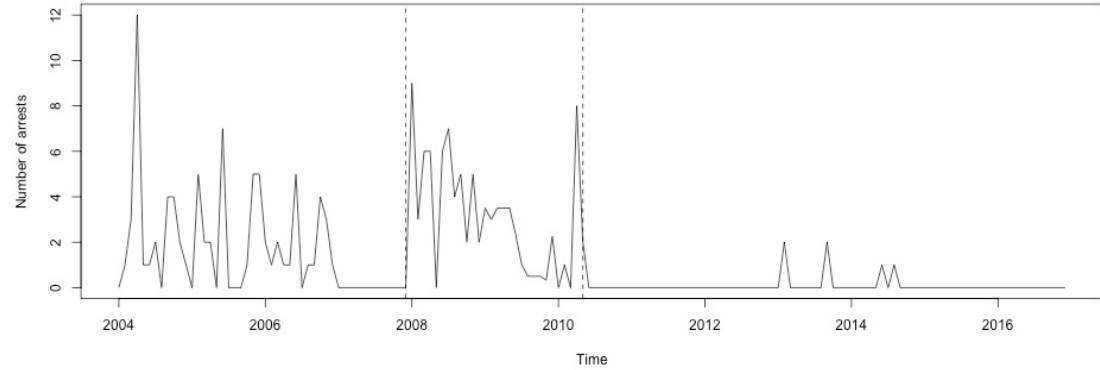
Figure A47. Heroin organized crime Czech nationals arrests 2004–2016 in the Czech Republic and structural breaks.